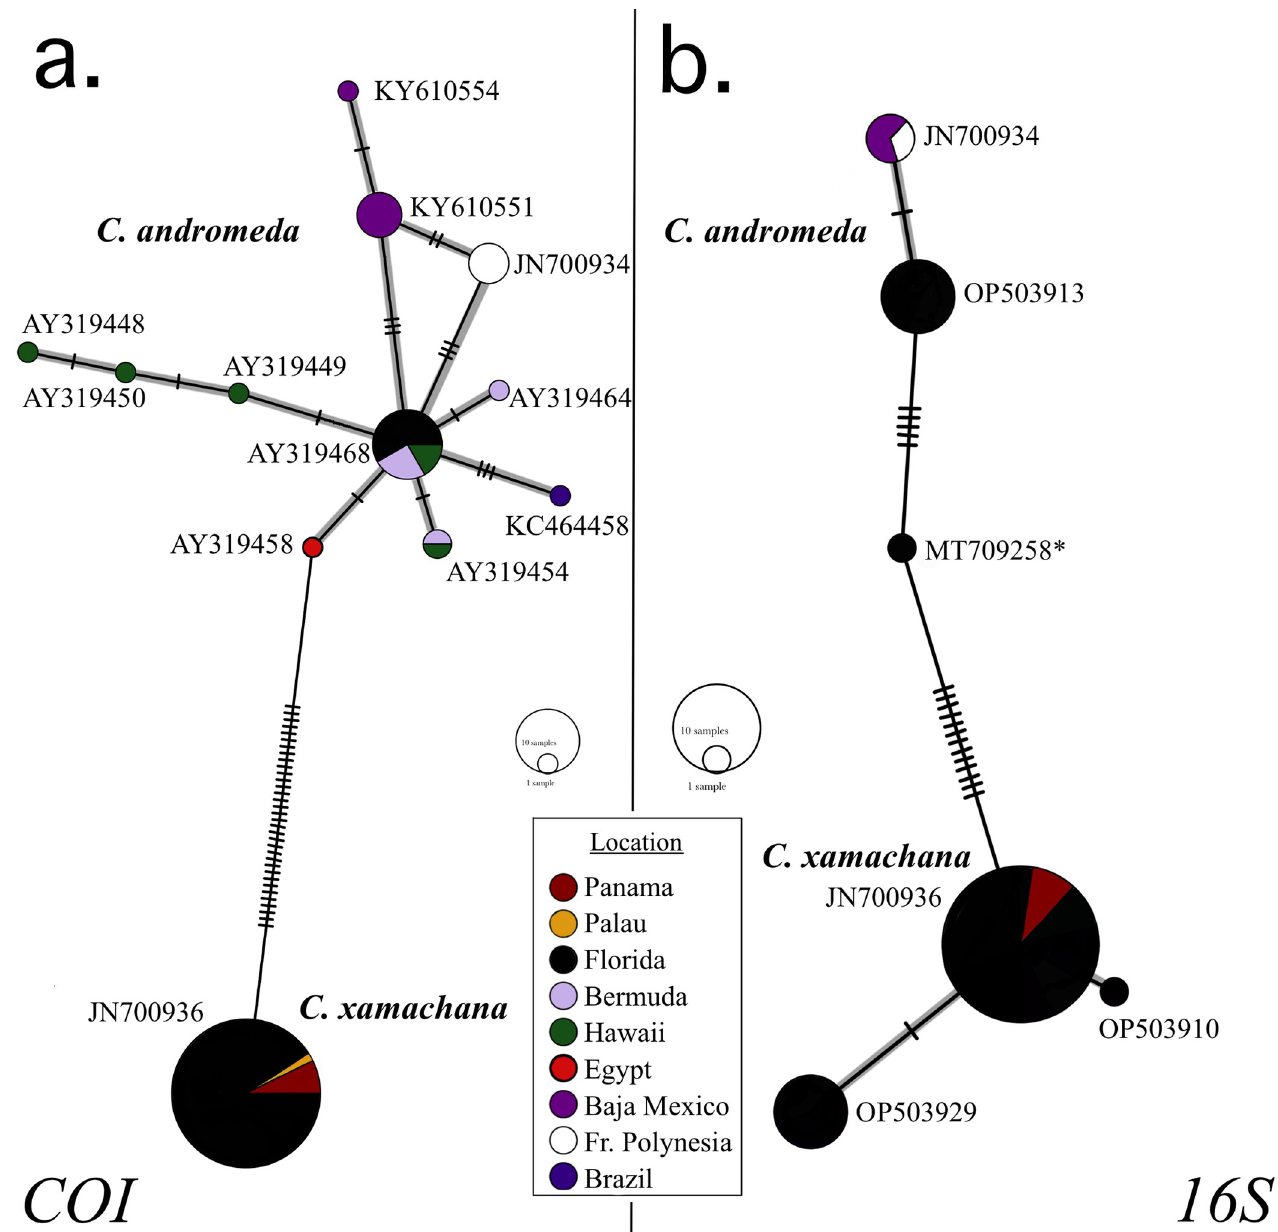
Fig 3. Haplotype network for C . xamachana and C . andromeda . (a) COI haplotype network and (b) 16S haplotype network. One accession number that is consistent with the haplotype is displayed next to each group. Sequence MT709258 * is a product of eDNA work and may not represent a genuine haplotype. Grey highlight connects all sequences from each